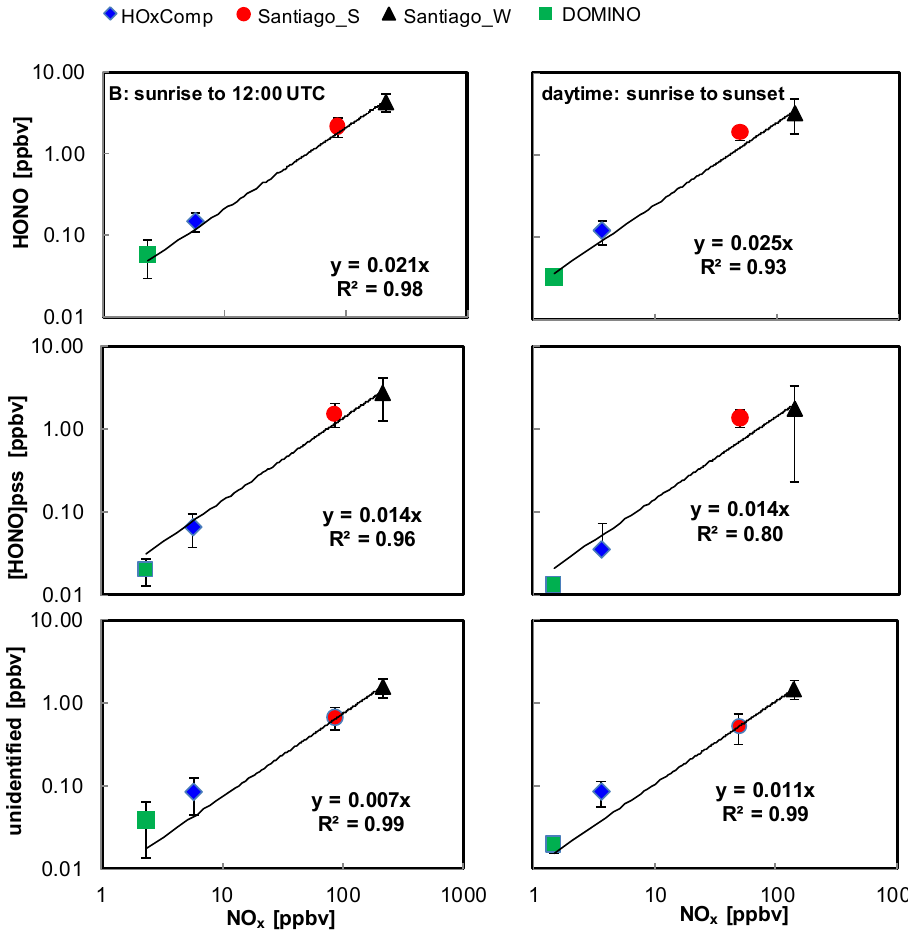
Fig. 7. Correlation between HONO, [HONO]pss, unidentified HONO and NO x during sector B (left, sunrise to 12:00 UTC) and during daytime (right, sunrise to sunset). Error bars represent 1 σ of the mean.